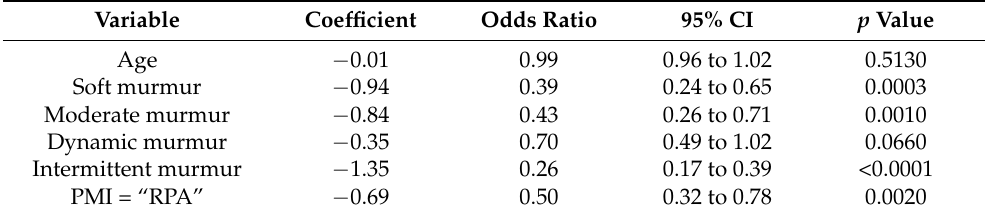
Table 3. Result of multi-variable analysis showing the association between the probability of iden- tifying a structural cardiac disease on echocardiographic examination and cat and heart murmur characteristics that were significant in the univariable